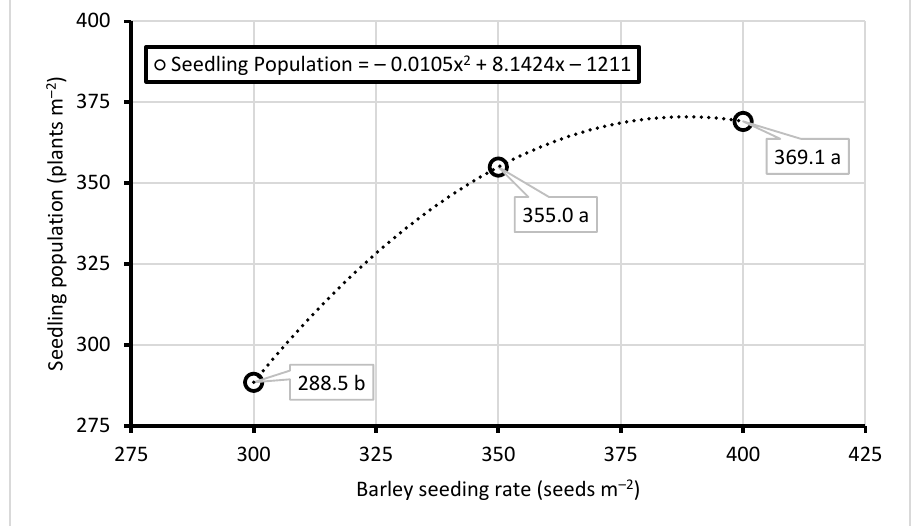
Figure 4. Mean seedling population (plants m – 1 ) as a function of barley seeding rate. Means followed by the same letter are not significantly different from each other according to Bonferroni adjusted t-tests at p ≤ 0.05.